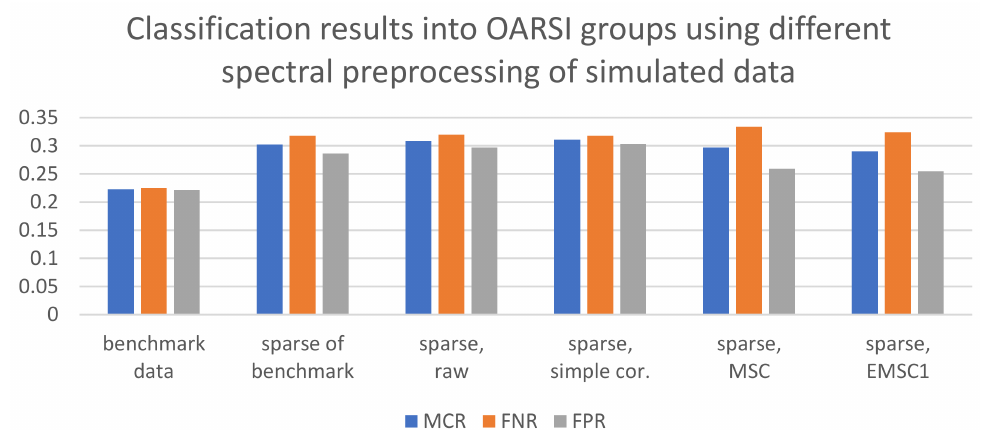
Figure 4. Binary PLSDA classification of healthy and damaged samples based on OARSI grades. Models were established using preprocessed simulated cartilage spectra. From left to right: (1) benchmark broadband data, (2) sparse spectra of the benchmark data, (3) sparse raw data, (4) sparse data with simple preprocessing, (5) sparse data preprocessed by MSC, (6) sparse data preprocessed by EMSC1. Overall misclassification rate (MCR = 1-Accuracy) as well as False Negative Rate (FNR = 1-Sensitivity) and False Positive Rate (FPR = 1-Specificity) for the damaged